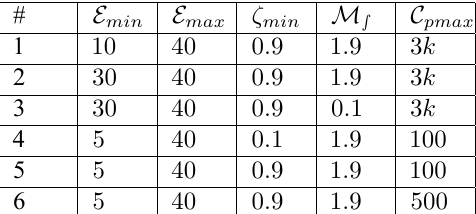
Table 5. Agent emotional parameters.